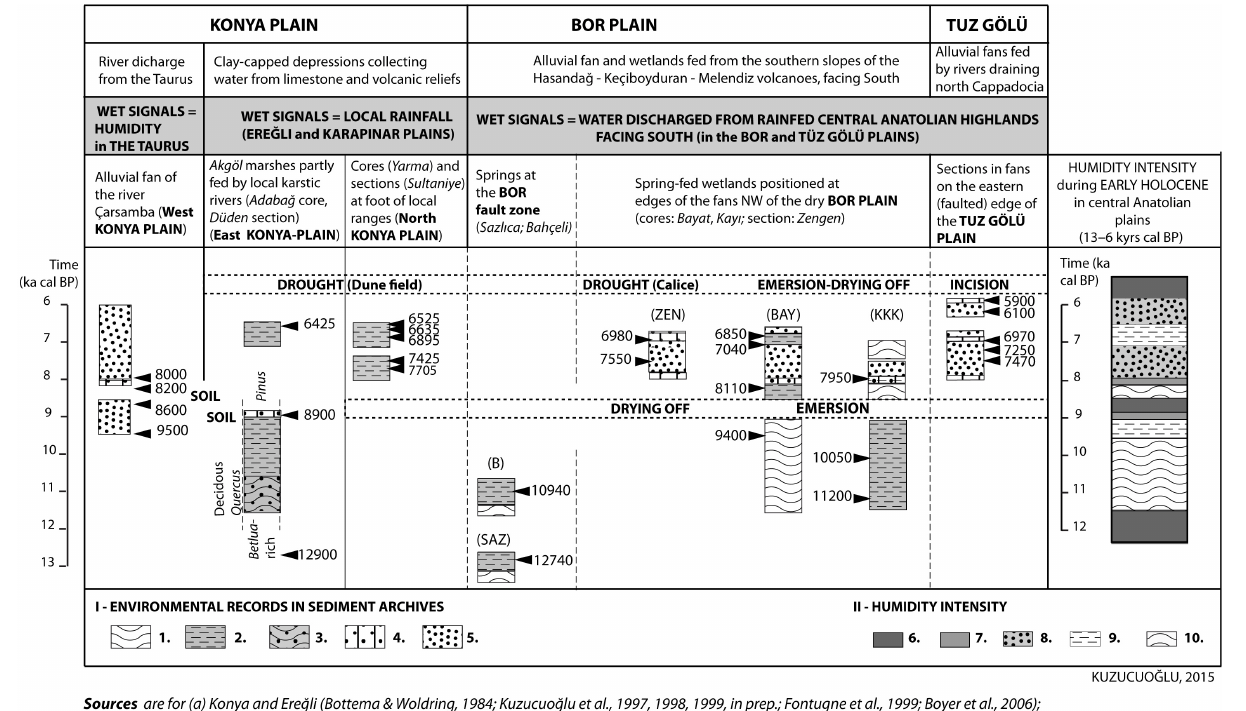
Figure 8. Dated palaeoenvironmental records in the three main endorheic plains of central Anatolia: a synthesis between 12.5 and 6.0ka cal BP. Environmental records in sediment archives: 1, deep lake; 2, backswamps; 3, vegetated shallow marshes; 4, palaeosol; 5, alluvial fan (coarse sediment). Humidity intensity (synthesis): 6, dry to very dry; 7, emersion of watered ecosystems and soil formation; 8, semi-arid and/or contrasted seasonal climate (high seasonal run-off); 9, humid (marshes); 10, very humid (lakes,